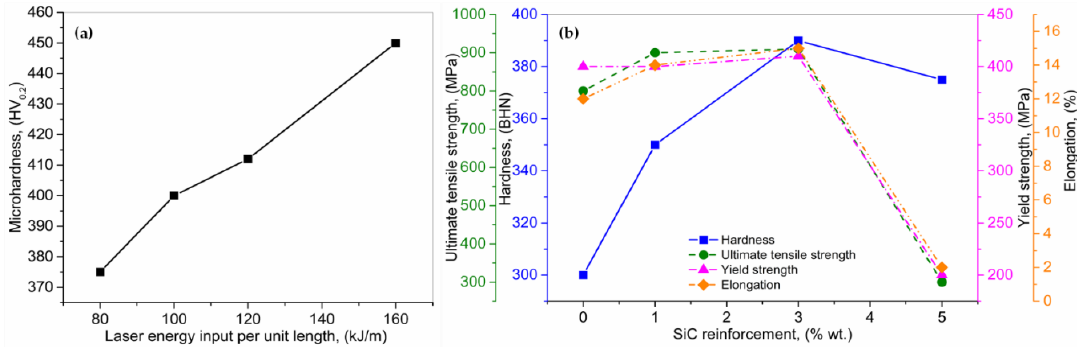
Figure 11. ( a ) Analyses of laser energy input over the unit length on microhardness, and ( b ) influence of SiC reinforcement (wt.%) on hardness, ultimate tensile and yield strengths, and elongation; based on the data provided in Ref. [144,145].